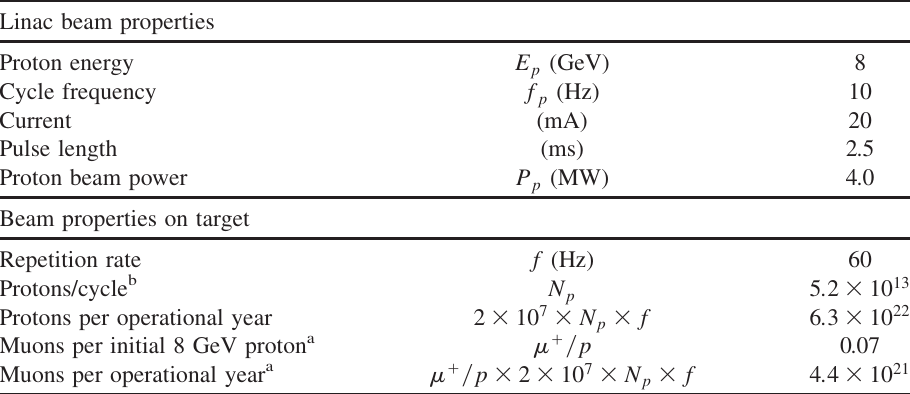
TABLE II. Representative proton source parameters. The muon rates are for positive muons calculated at the end of the muon ionization cooling channel. There will be an approximately equal number of negative